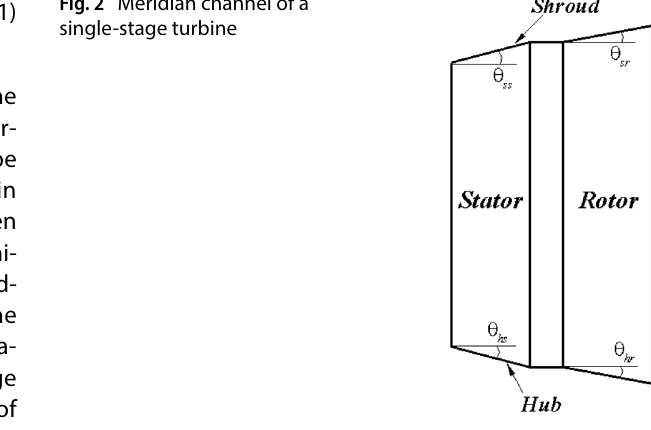
Fig. 2 Meridian channel of a single-stage